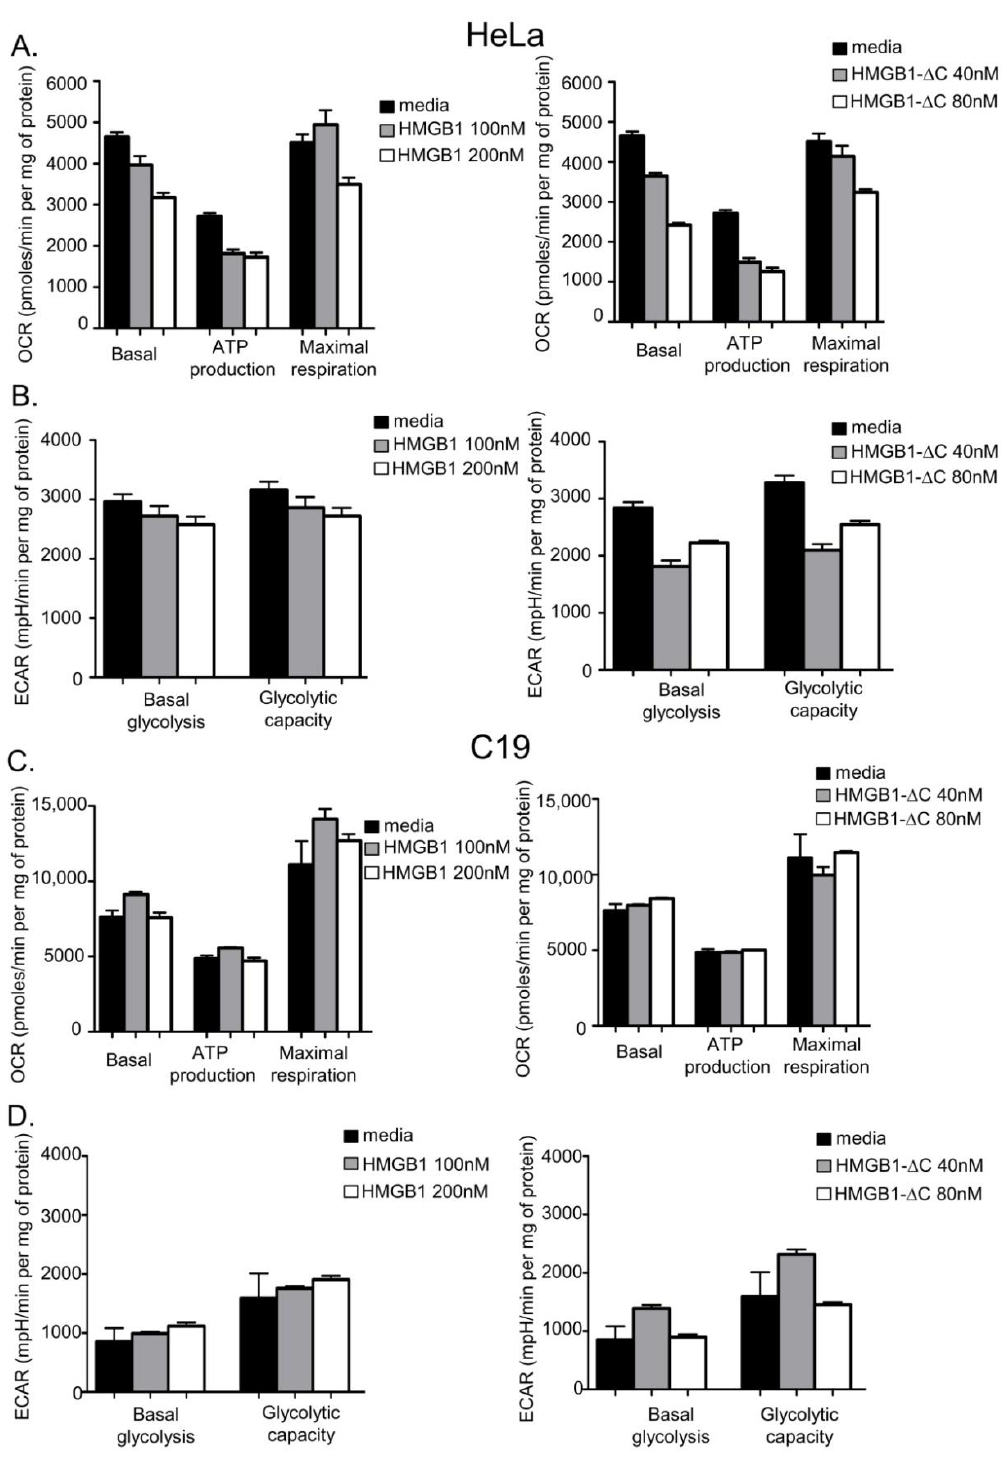
Figure 6. Acute effects of increasing concentrations of HMGB1-fl and HMGB1- ∆ C on HeLa ( A , B ) and C19 ( C , D ) cell bioenergetics. ( A ) HeLa cells were seeded in a Seahorse XFe24 plate, treated for 48 h with HMGB1-fl (left panel) or HMGB1- ∆C (right panel) and basal OCR measurements were made followed by injection of oligomycin (1 µM), FCCP (1 µM) and rotenone (10 µM) + antimycin A (10 µM). ATP linked respiration is the difference in OCR before and after oligomycin injection. Maximal respiration is defined as the OCR after FCCP injection. Non-mitochondrial respiration was determined after rotenone + antimycin A injection. The rates of basal respiration, ATP-linked respi- ration and maximal respiratory capacity were normalized with the total amount of proteins present in each well. OCR is expressed in pmoles per min per mg of protein. The data shown are